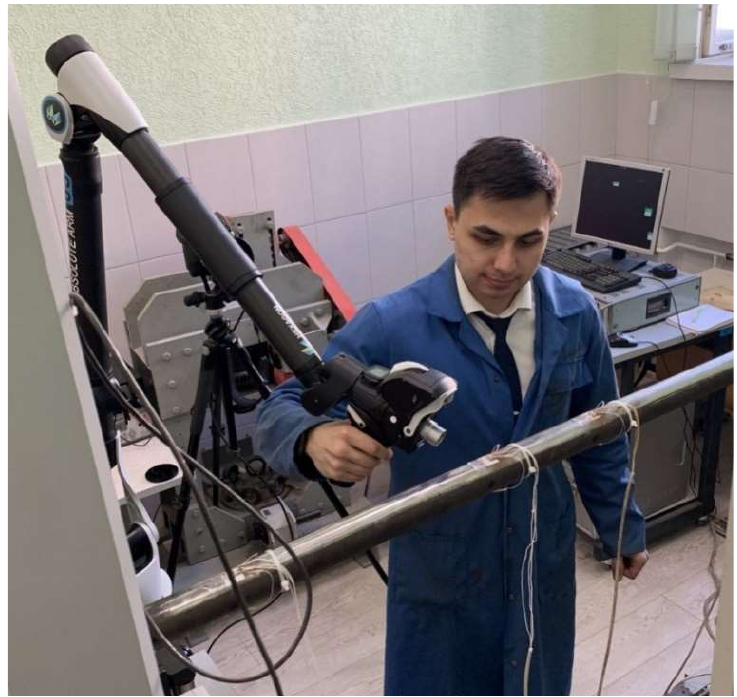
Figure 14. The process of laser scanning of the investigated pipeline.